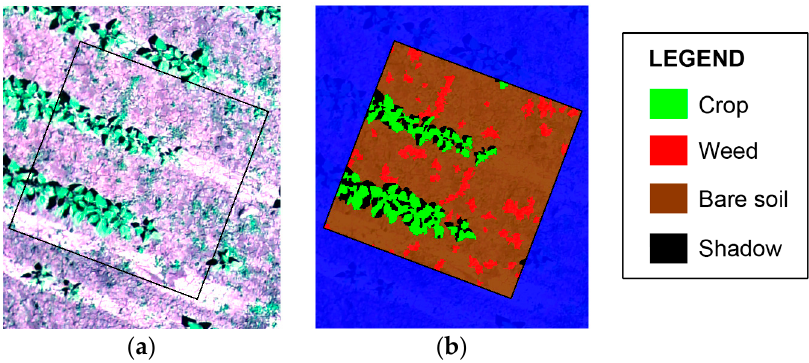
Figure 6. Detail of a validation frames in field S1–16: ( a ) original image (G-NIR-R composition); ( b ) manually classified frame.